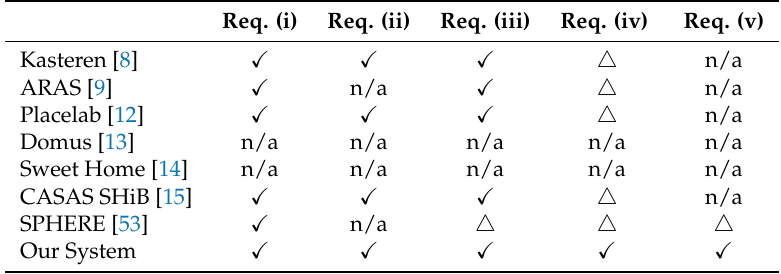
Table 1. Comparison with existing systems related to our